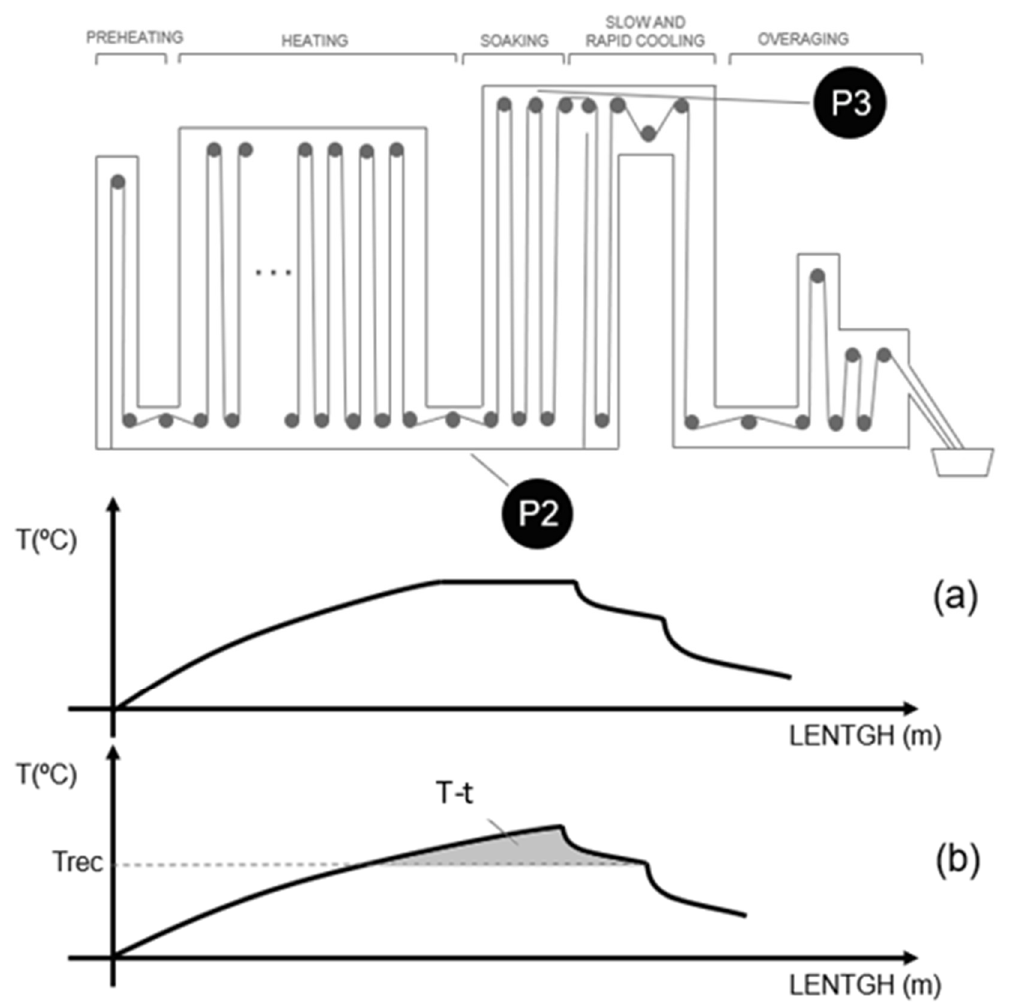
Figure 1. Layout of the annealing furnace, and thermal profiles of the strip with soaking ( a ) and without soaking ( b ). The value of the temperature-time T-t parameter is the area indicated by the shaded area (T-t).